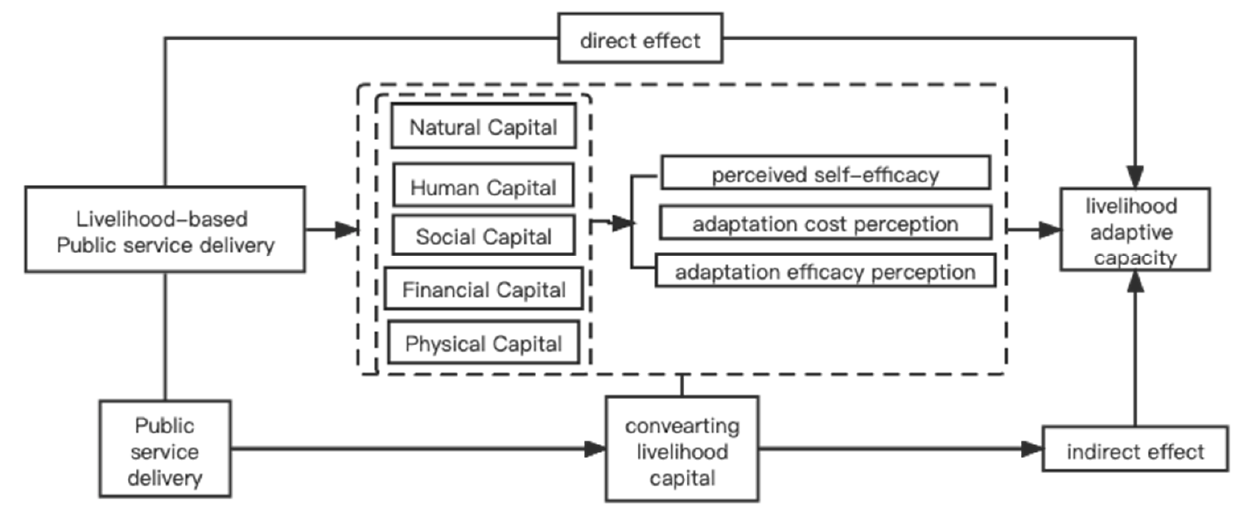
Figure 1. Analytical framework of the public service delivery–livelihood capital–livelihood adaptive capacity of farmers and herders process.